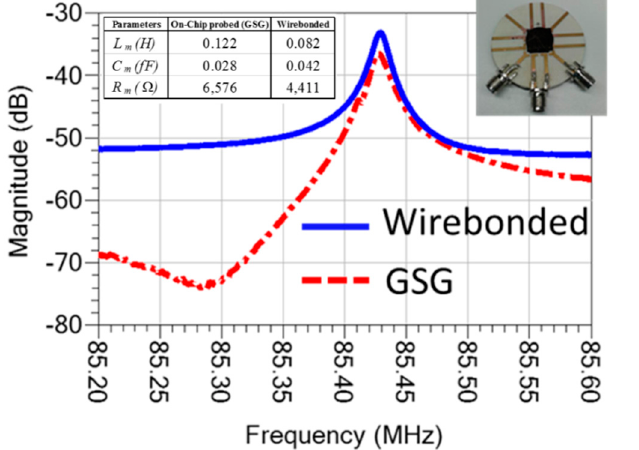
Figure 5. Frequency responses of a fourth-order contour-mode disk resonator measured using an on-chip ground-signal-ground (GSG) probing and a PCB chip carrier with bond